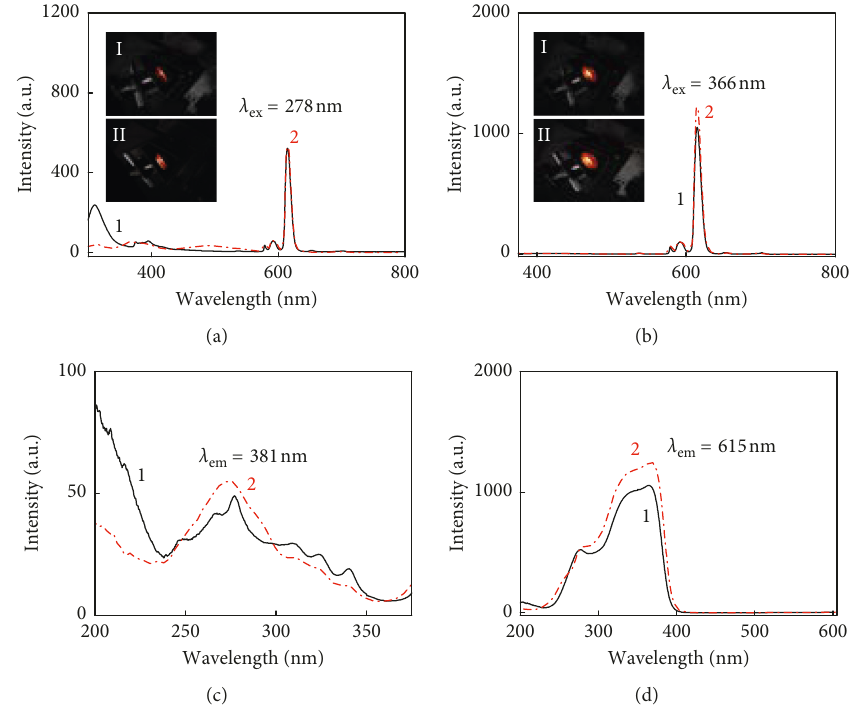
Figure 5: Emission (a, b) and excitation (c, d) spectra of Eu(BA)(TTA) 2 /PVP (curve 1) and Eu(BA)(TTA) 2 Phen/PVP (curve 2). Insets: fluorescence of Eu(BA)(TTA) 2 /PVP (I) and Eu(BA)(TTA) 2 Phen/PVP (II),